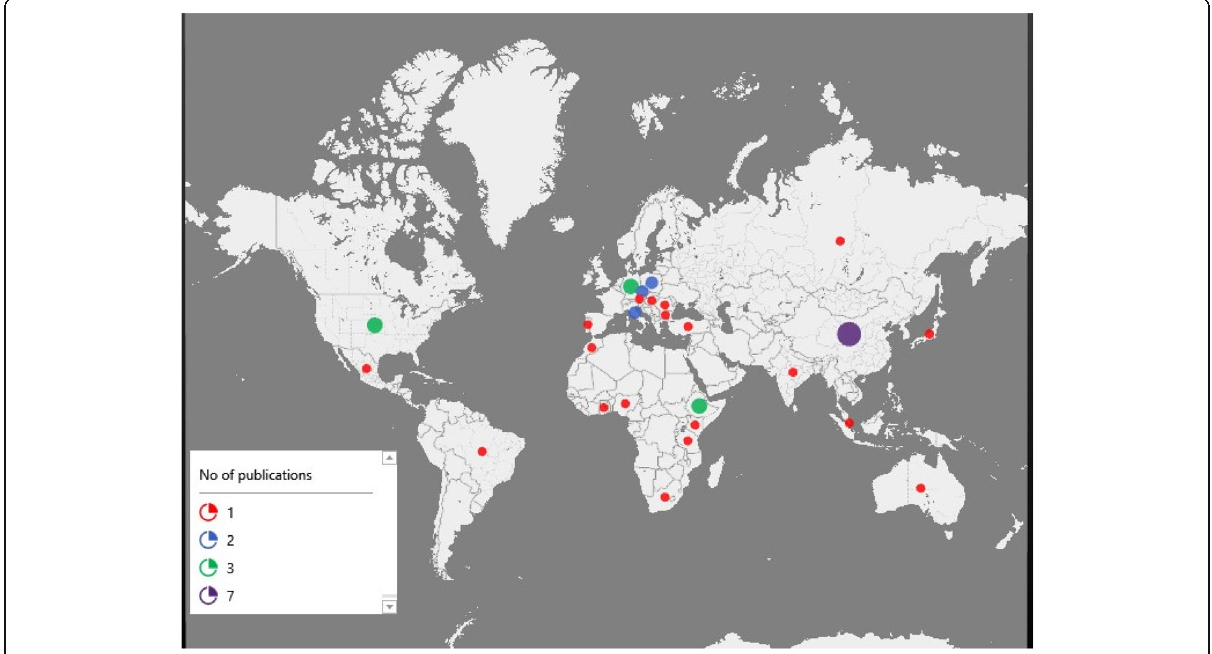
Fig. 2 The distribution of RES case studies globally based on study location ( N = 46 studies which specified a geographic location). The publications on RES that were published from 2005 to 2019 demonstrate a broad spread across the globe, with a relatively notable concentration of studies in Europe and